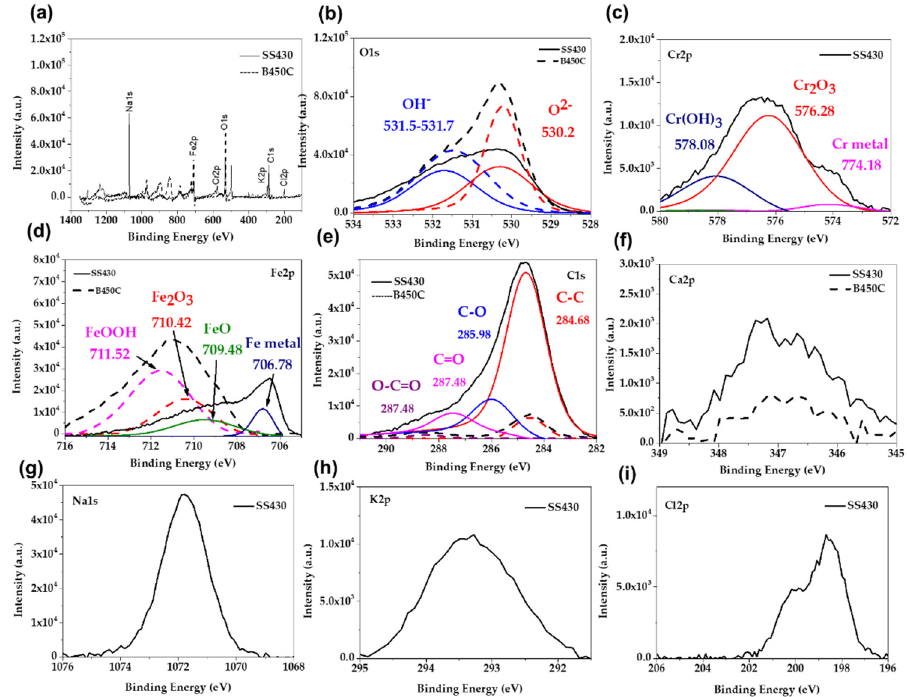
Figure 4. Overview of X-ray photoelectron spectroscopy (XPS) spectra acquired from SS430 and B450C steels exposed to SS1 cement extract for 30 days: ( a ) full spectrum; spectrum for ( b ) O1s; ( c ) Cr2p; ( d ) Fe2p; ( e ) C1s ( f ) Ca2p; ( g ) Na1s; ( h ) K2p; ( i ) Cl2p.